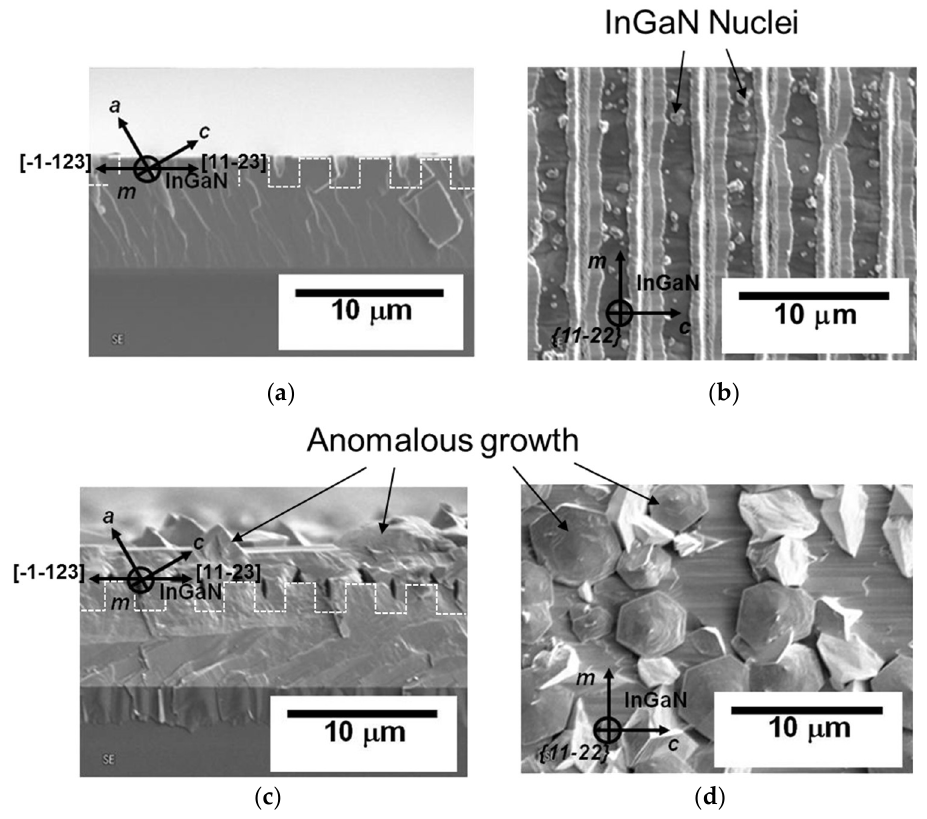
Figure 4. Cross-sectional and plan-view SEM images of the {11-22} InGaN layers grown on the GaN template at a growth temperature of 800 ◦ C, at the initial stage of growth ( a , b ), and after coalescence ( c , d ).